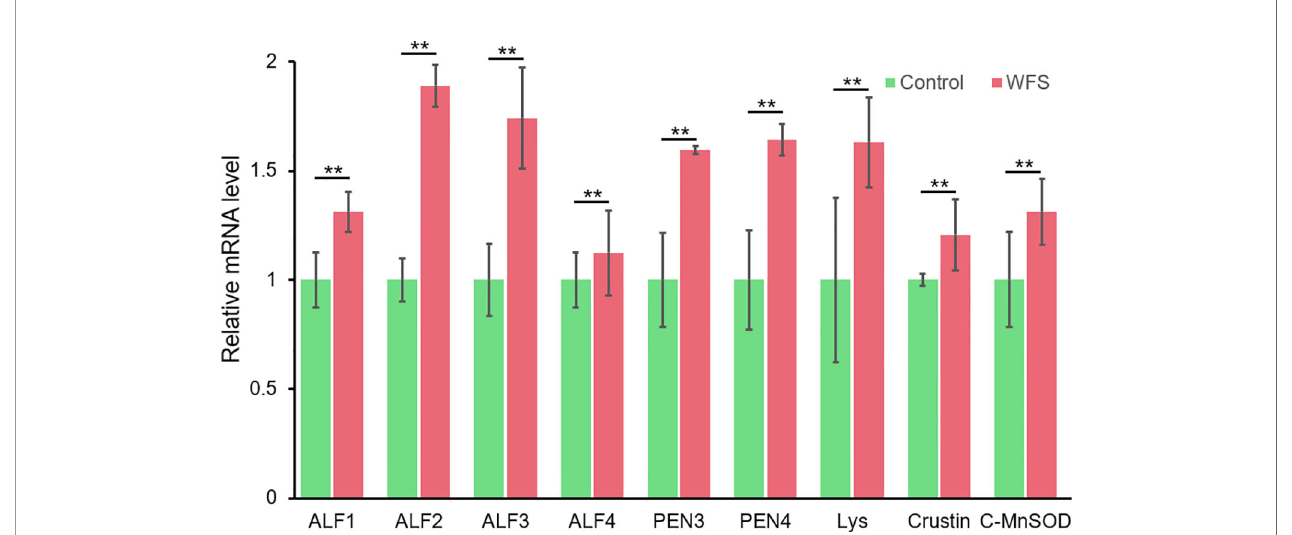
FIGURE 7 | Comparison of the expression of various antimicrobial related genes between Control and white feces syndrome (WFS). Each bar represents the mean ± SD of the samples. Signi fi cant differences are indicated by asterisks (**, P <